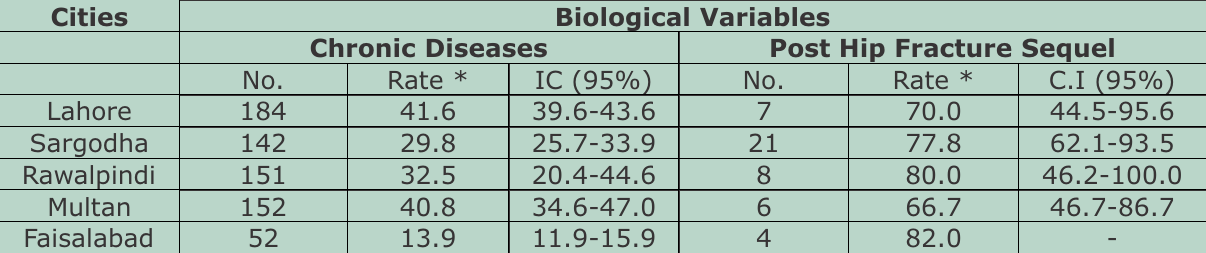
Table-III: Prevalence of physical disability in the Senior Citizens according to biological variables and